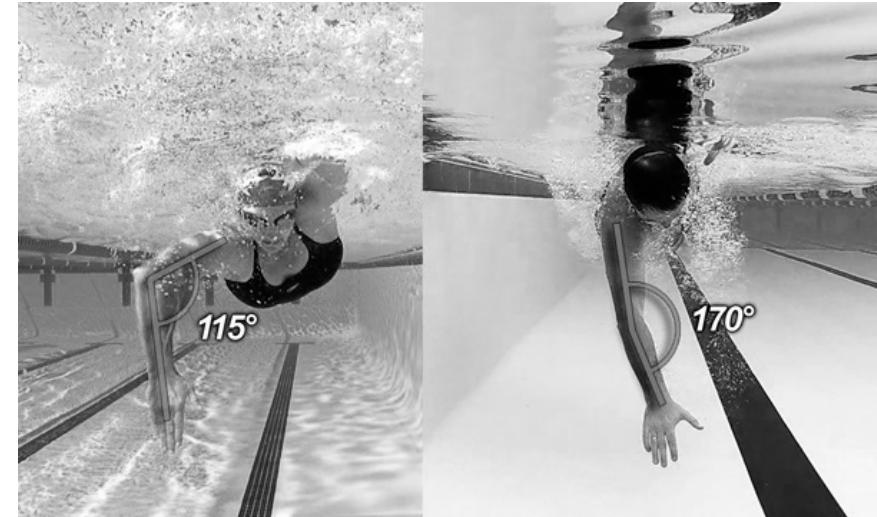
Figure 21. Comparison of different elbow angles produced during the insweep phase of frontcrawl swimming. Measuring these angles allows coaches to optimise technique and maximise propulsive force generation [109].